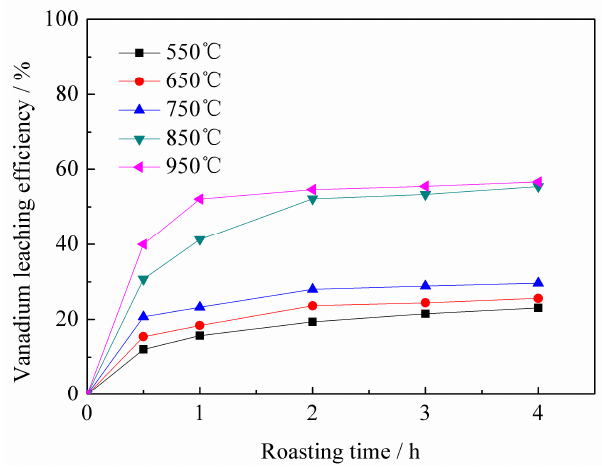
Figure 5. Effect of roasting temperature on vanadium leaching efficiency.